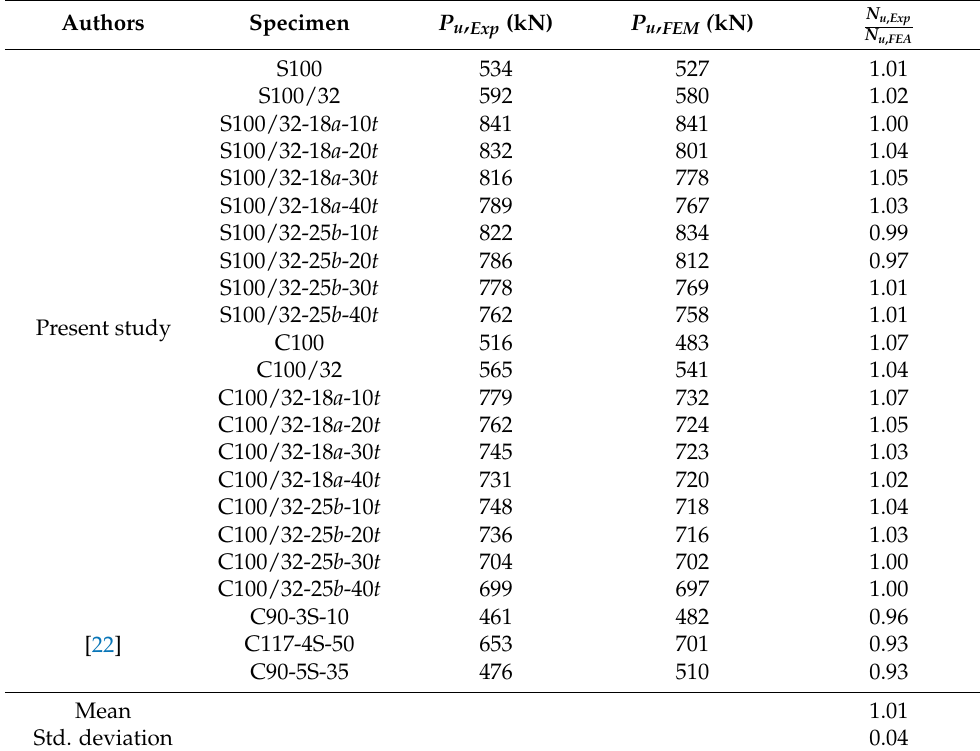
Table 8. Comparison of the finite element model with the experimental